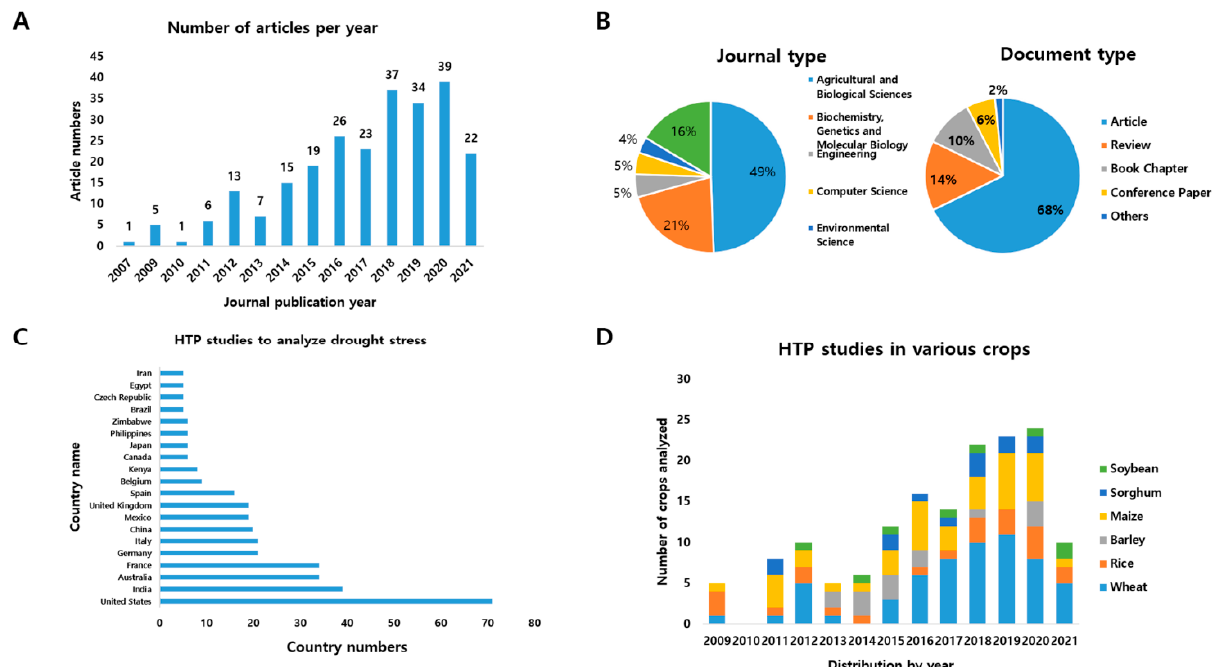
Figure 1. Status of high-throughput phenotyping and drought stress studies performed in 2007–2021. ( A ) The number of journals per year. ( B ) Journal and document type. ( C ) HTP studies to analyze drought stress. ( D ) HTP studies in various crops.